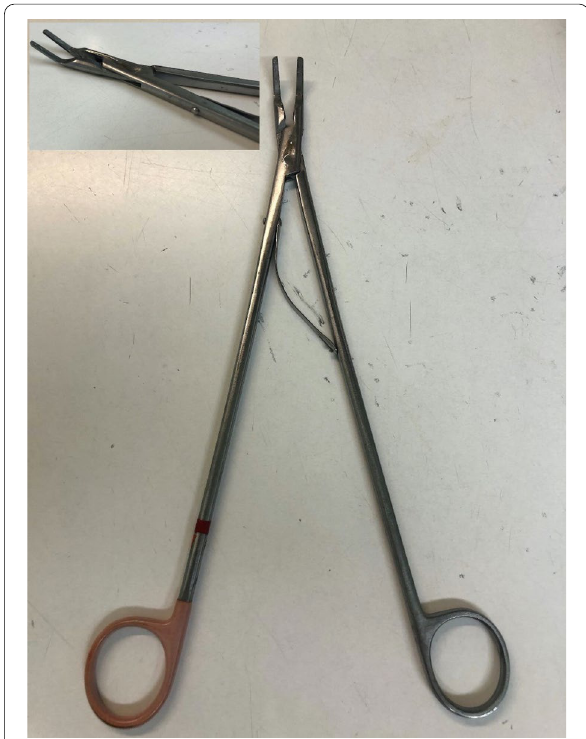
Fig. 3 Liga-clip applicator which was used for the removal of the foreign